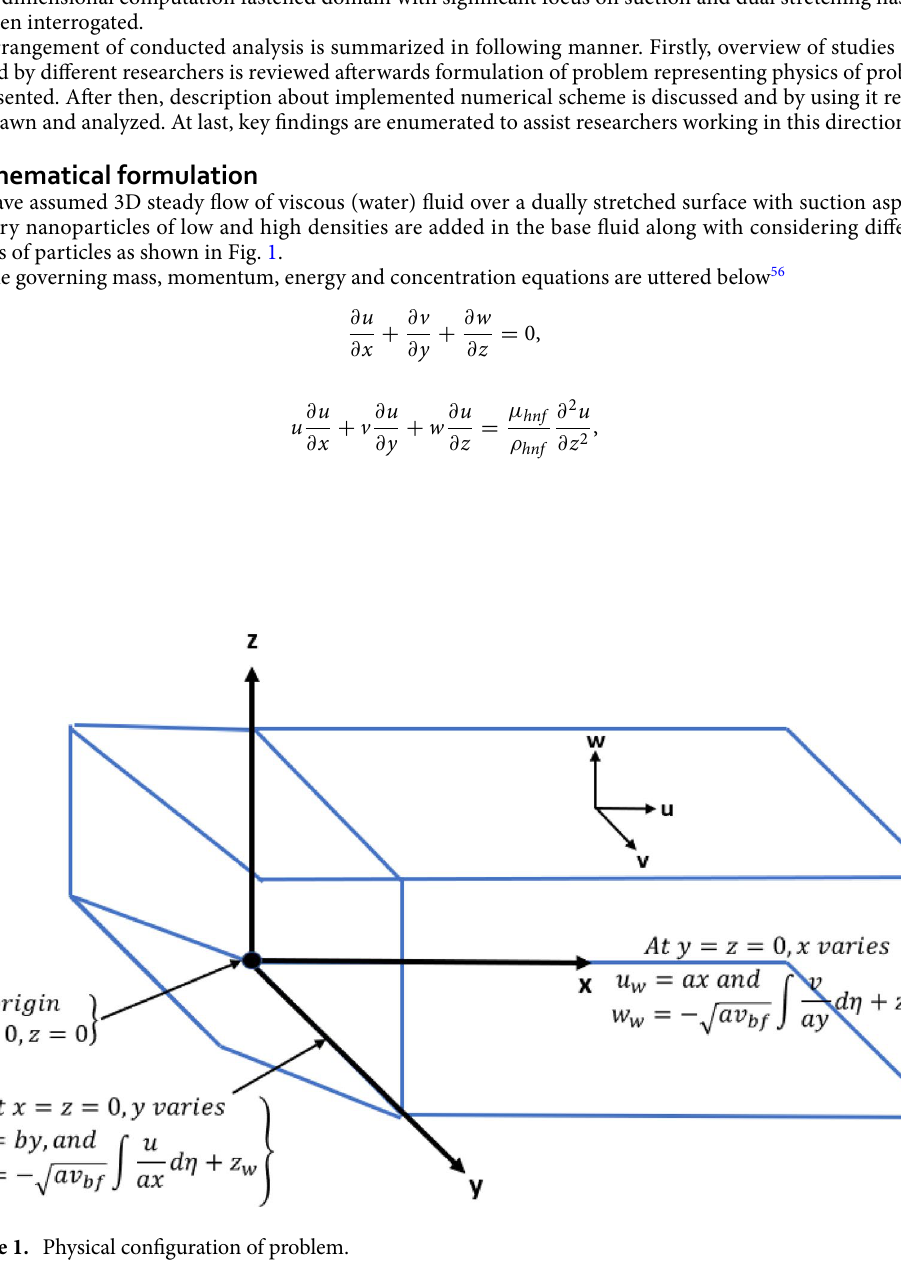
Figure 1. Physical configuration of